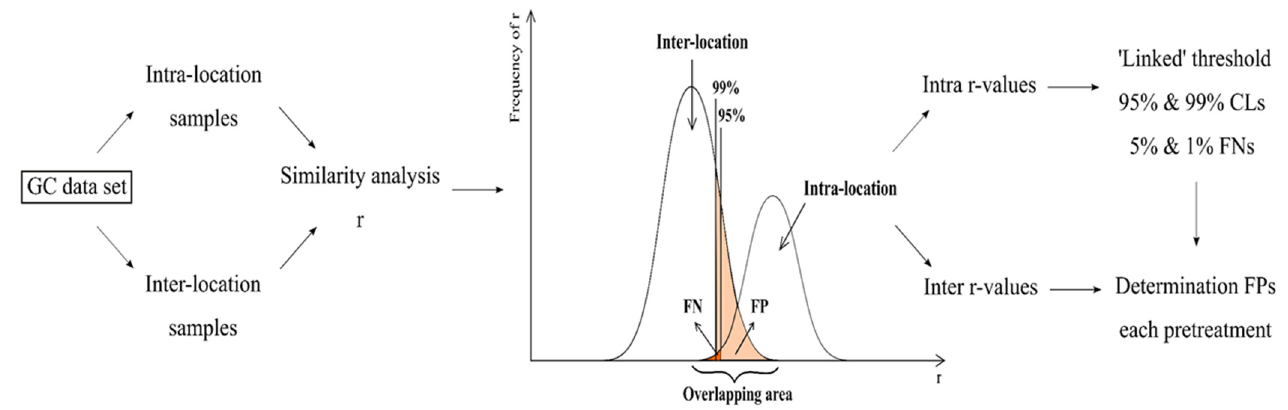
Figure 6. Schematic overview of the methodology used to evaluate the discriminating power of the studied pre-treatments. ROC Analysis